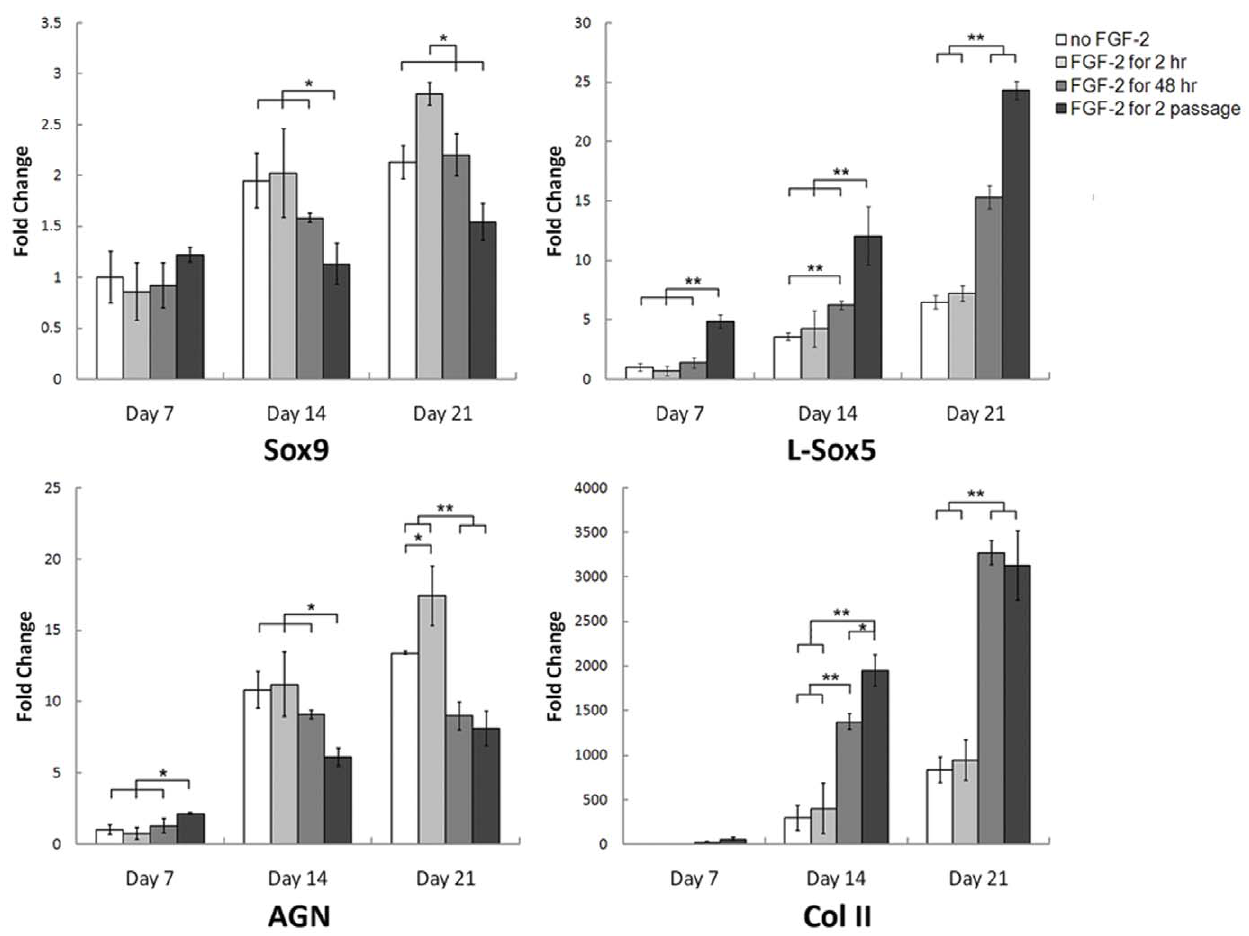
Figure 3. FGF-2 enhances hMSC CG through both selection- and priming-based mechanisms. Human MSCs were expanded for 2 passages in medium supplemented with FGF-2 for varying durations of time and assayed for cartilage-specific gene expression in pellet culture up to 21 days using real-time RT-PCR. Longer durations of FGF-2 exposure during hMSC expansion resulted in the significant upregulation of L-Sox5 and Col II gene expression, while exposure to FGF-2 for just 2 hours resulted in the significant upregulation of Sox9 and AGN by Day 21. All values were normalized to GAPDH expression and compared to the non-FGF-2-expanded control at Day 7. Values are represented as mean 6 SD. *p , 0.05, **p , 0.005,